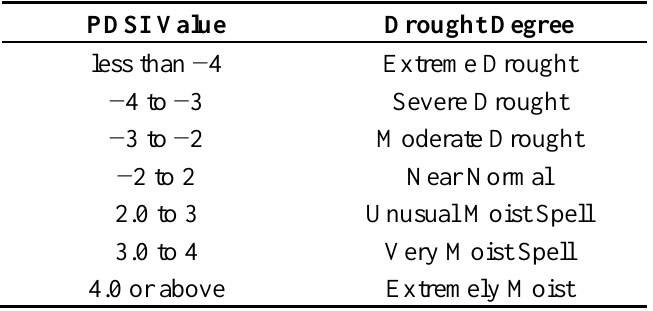
Table 1. Drought degree according to